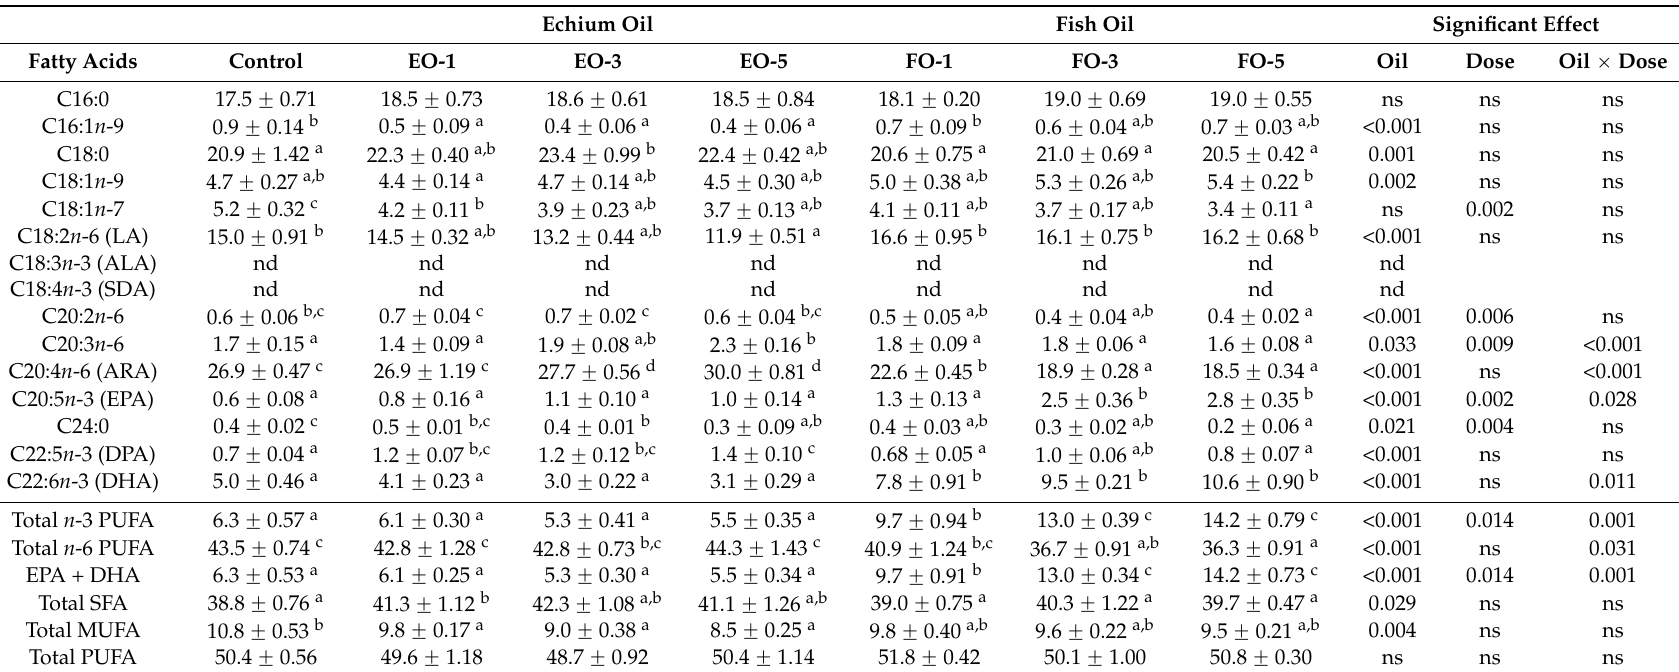
Table 4. Liver phospholipid fatty acid composition in rats fed diets supplemented with Echium oil or Fish oil. Echium Oil Fish